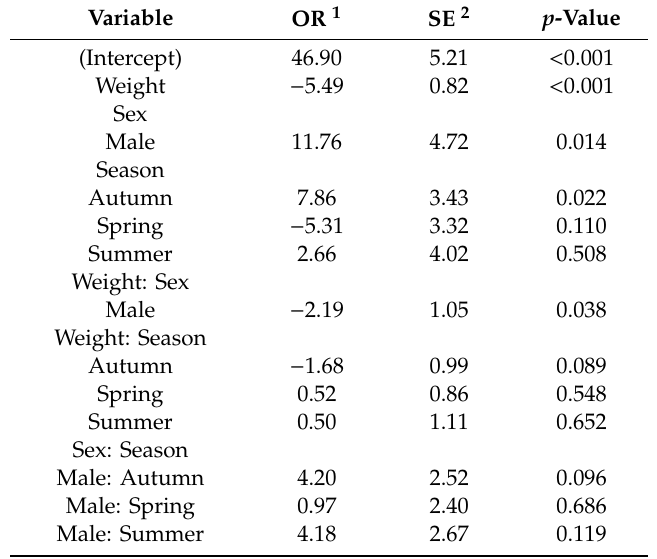
Table 3. Odds ratio and associated statistic of fixed e ff ects included in the final intake model of kennel